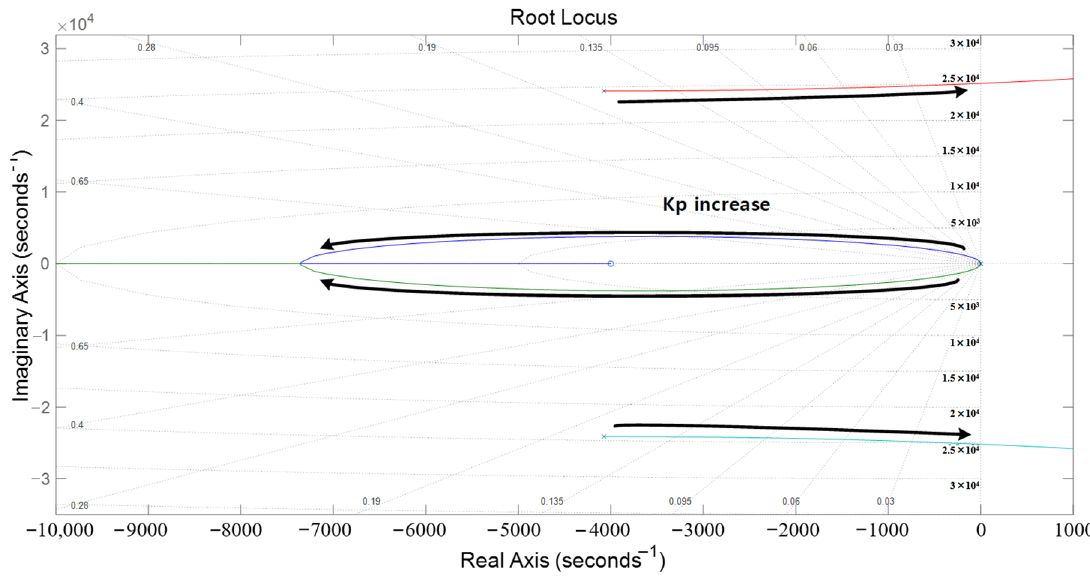
Figure 3. Root locus of the GCI current control system applying the CFF control.